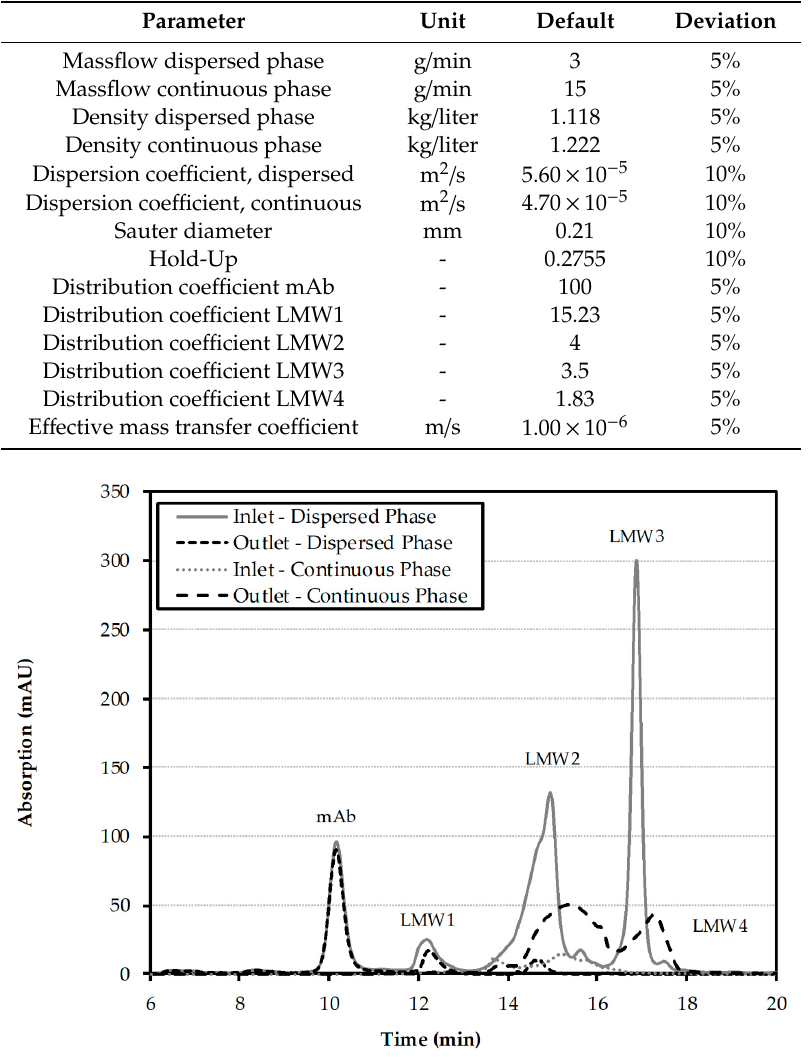
Processes 2019 , 7 , x FOR PEER REVIEW Figure 10. Size exclusion chromatograms of the inlet and outlet streams of the wash extraction [7]. Table 6. Process and model parameters for the wash extraction from [7]. The default values of the simulation equal the experimental process parameters. The dispersed phase enters the column at the bottom; the continuous phase inlet is at the column top.